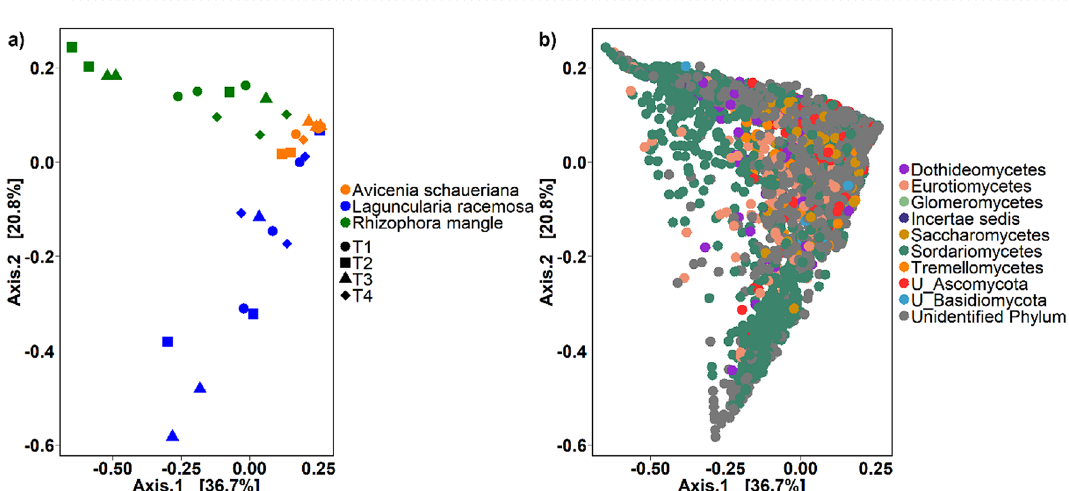
Figure 2. The most abundant fungi families assembled in the three plant species ( Avicennia schaueriana, Laguncularia racemosa and Rhizophora mangle ) during the decomposition process. ( a ) Principal Coordinated analysis (PCoA) showing the β diversity of the six most abundant families in the three plant species in the four collection times (7, 15, 30, 60). The first axis explained 38.2% of the data while the second axis explained 23.4%. ( b ) Principal Coordinated analysis showing the β diversity of the six most abundant phyla in the three plant species where each dot represent an OTU colored according to the phylum level of the taxonomic